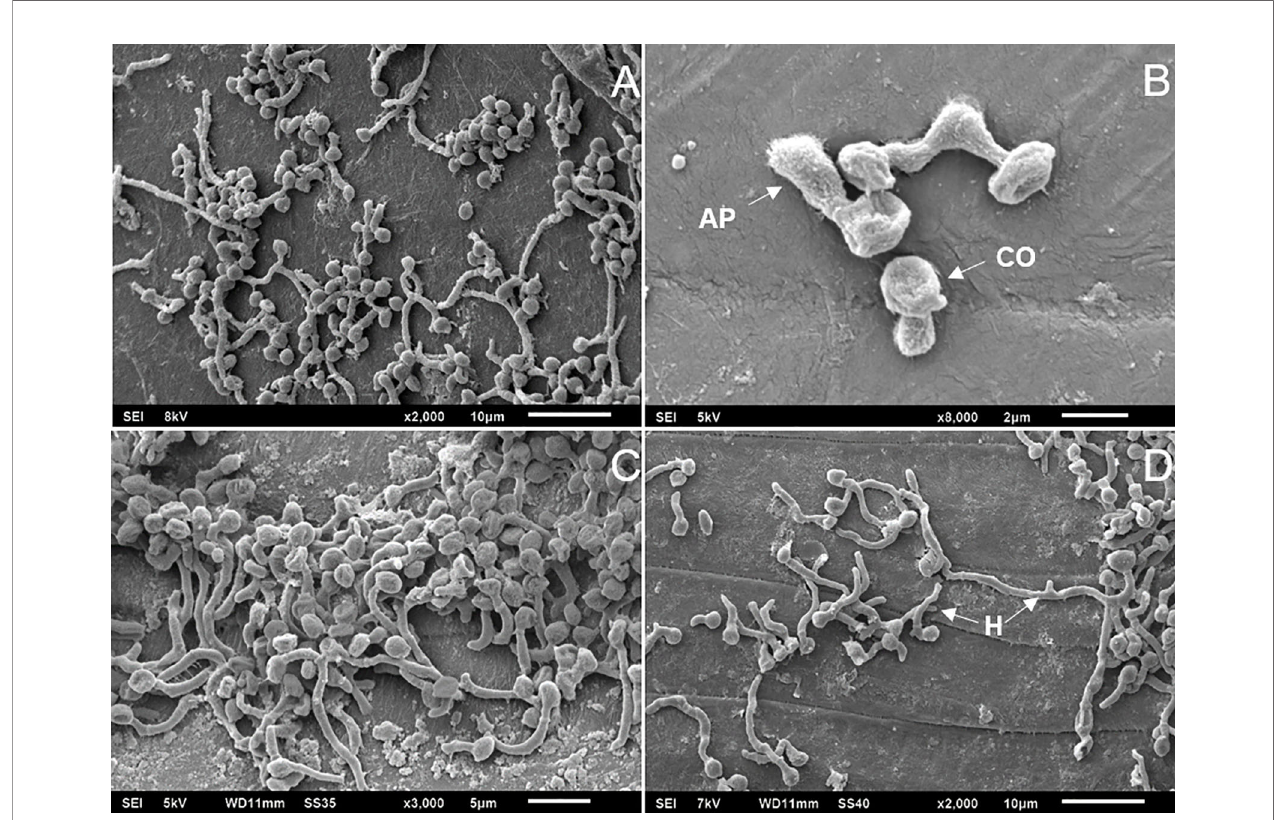
FIGURE 3 | Electron micrographs of Rhipicephalus microplus engorged females treated topically with conidia of Beauveria bassiana strains: BbWT , D Bbmsn2/ Bbmsn2 or D Bbmsn2 , and incubated for 48 h at 26 ± 1°C and RH ≥ 90%. Germinating conidia of BbWT on the tick cuticle (A) Germinating conidia of D Bbmsn2/ Bbmsn2 with developed appressorium on the tick cuticle (B) Germinating conidia of D Bbmsn2/Bbmsn2 on the tick cuticle (C) Germinated conidia of D Bbmsn2 [some with long germ tubes (hyphae)] on the tick cuticle (D) . CO, conidia; AP, appressorium; H,